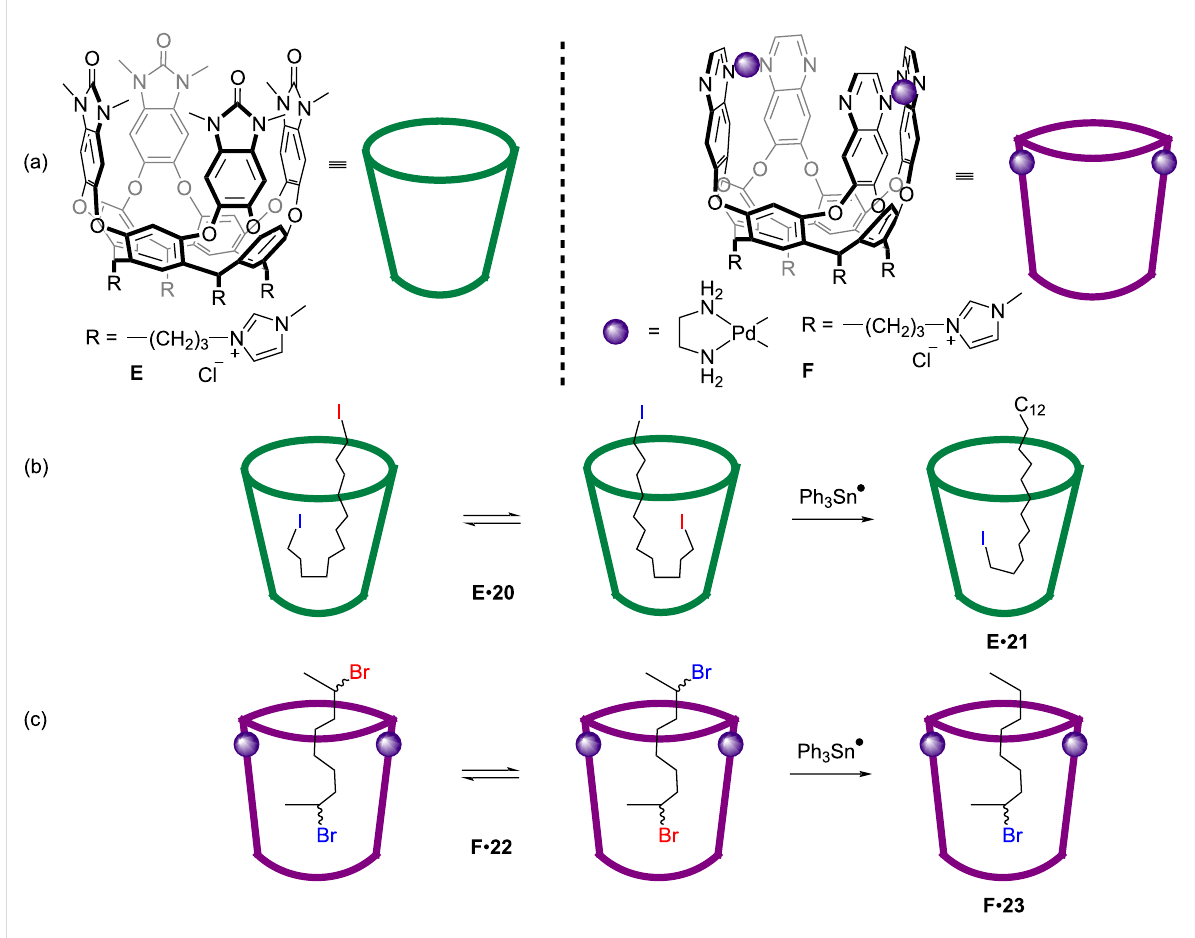
Figure 6: Selective radical reduction of α , ω -dihalides mediated by water-soluble cavitands E and F .